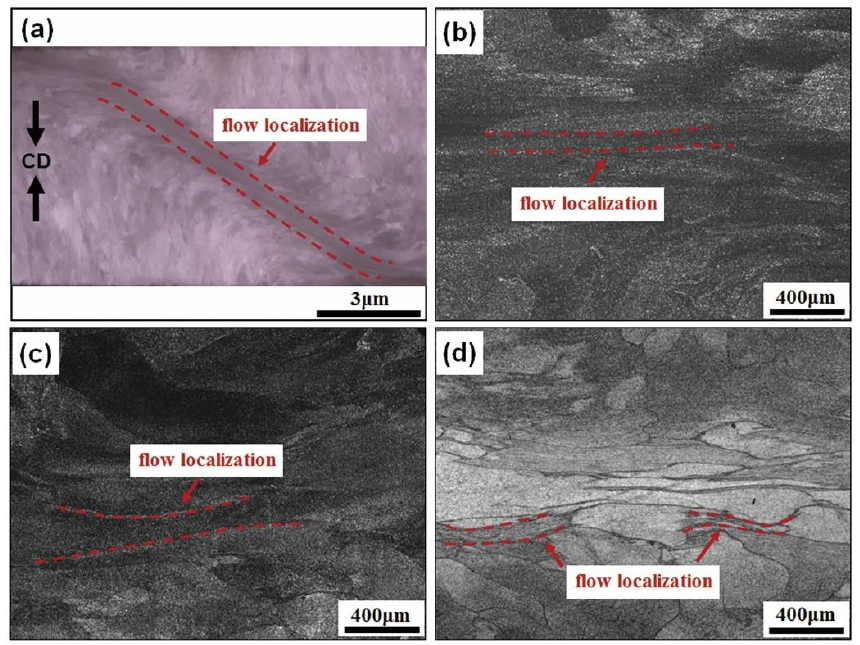
Figure 8. Optical microstructures of TB18 alloy in instability region: ( a ) 650 °C/10 s − 1 , ( b ) 750 °C/1 s − 1 , ( c ) 820 °C/10 s − 1 , ( d ) 850 °C/1 s − 1 .